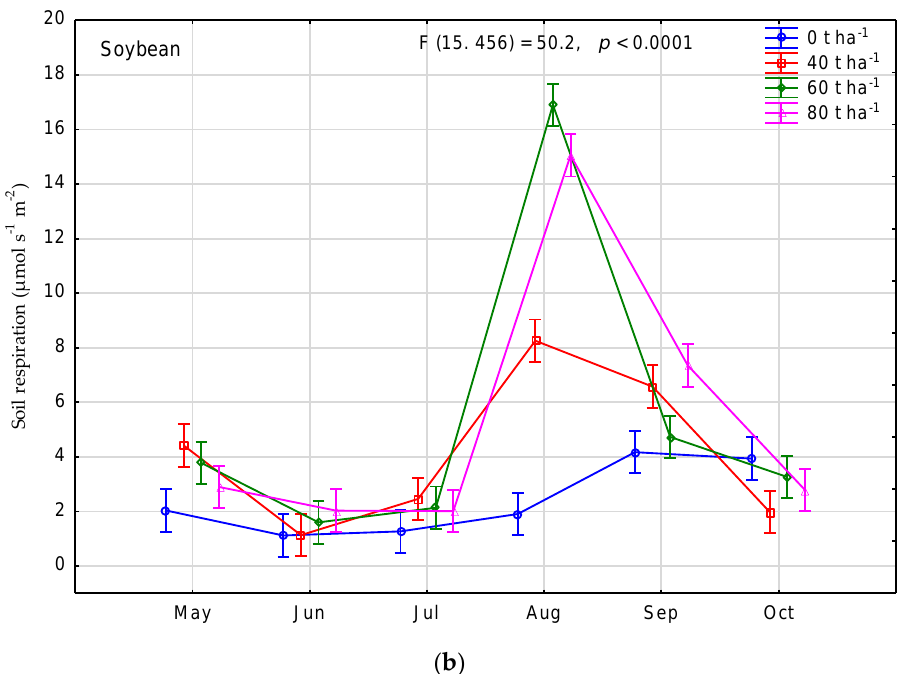
Figure 5. Soil respiration as a convergent effect of the dates of measurements and the dose of biochar in the objects measured: ( a ) without a protective plant, and ( b ) with a protective plant.